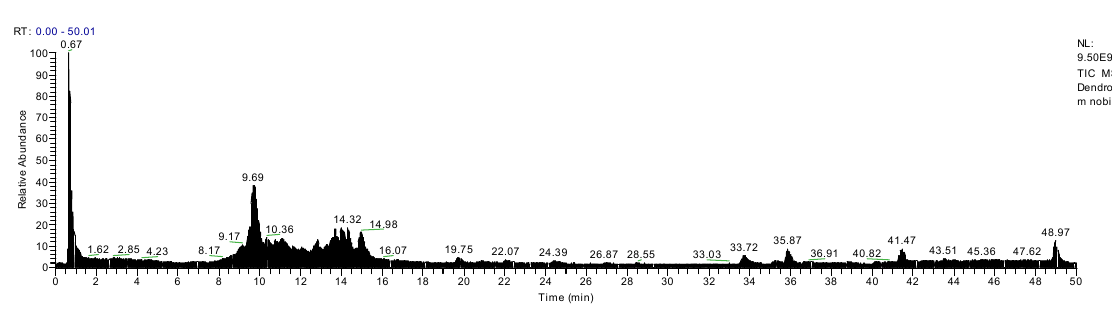
Figure 1. TIC chromatogram of D. nobile extract by UPLC-ESI-Q-Orbitrap. Nine alkaloids were identified from DNE. Alkaloids in D. nobile responded well in the positive ion mode. The molecular formula of DN (compound from D. nobile ) 10 was accurately predicted as C 16 H 25 NO 2 by the quasi-molecular ion peak ([M+H] + ) at m / z 264.19507 (ppm − 2.784). The fragment ion m / z 236.20093 [M+H-2CH 2 ] + was produced